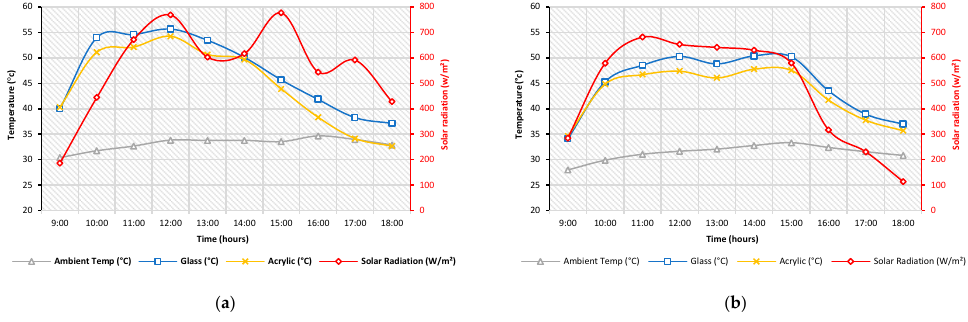
Figure 12. Variation in solar intensity and internal side temperature: ( a ) 21 February 2020 and ( b ) 1 August 2020.